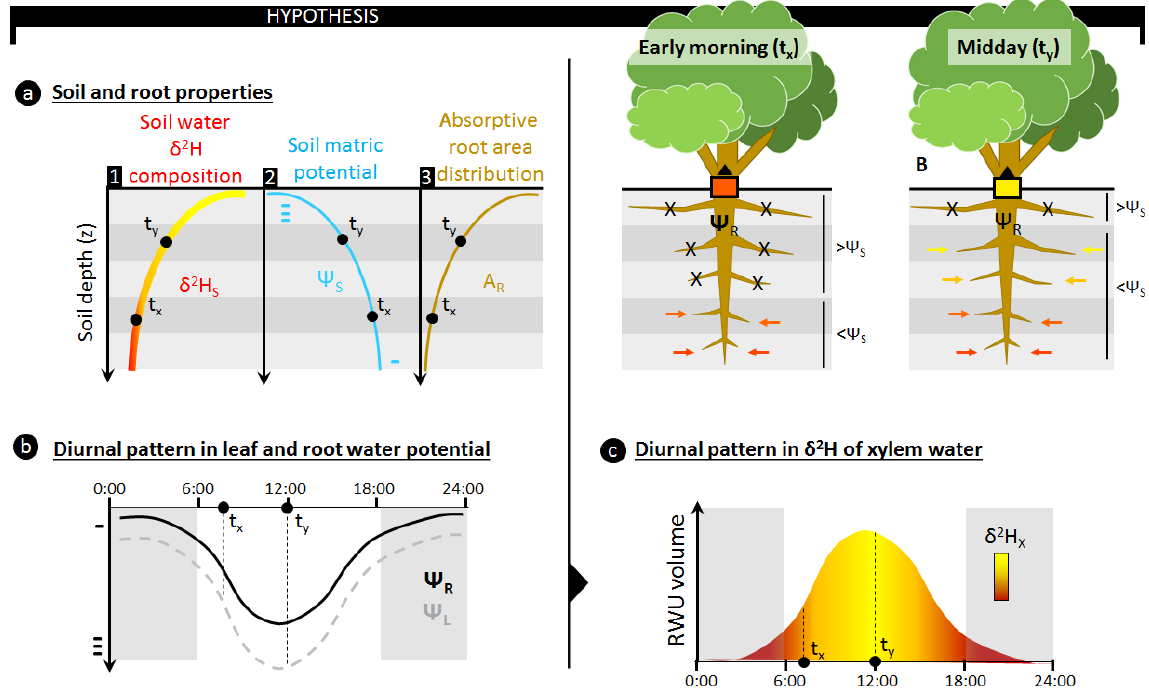
Figure 1. The use of stable water isotopes ( δ 2 H and δ 18 O) to assess the relative depth of root water uptake (RWU) requires a depth gradient in isotopic composition of soil water ( δ 2 H S ) to be present ( a , sub-panel 1) as only then can the relative contribution of different soil layers to the isotopic composition in a plant’s xylem water ( δ 2 H X ) be derived. These δ 2 H S gradients occur naturally as the result of evaporative soil drying during drought conditions; however, these conditions also result in the formation of a gradient in soil matric potential ( (cid:57) S ), ensuring an increasing (cid:57) S with depth ( a , sub-panel 2). RWU and sap flow in plants are passive processes in which water flows in the direction of decreasing water potentials. Specifically for RWU, this implies that water influx through the absorptive root area ( A R ; a , sub-panel 3) of a plant’s root is facilitated whenever the water potential in the root ( (cid:57) R ) is more negative than the surrounding (cid:57) S . As A R and (cid:57) S are generally not uniform with soil depth ( z ), the relative contribution of a specific soil layer to RWU will depend on (i) the difference between (cid:57) S and (cid:57) R in that soil layer and (ii) the relative amount of absorptive root area in that soil layer. Stable water isotope techniques assume that the δ 2 H X reflects the contribution of δ 2 H S from all soil layers. However, this does not account for the diurnal fluctuations in (cid:57) R which are invoked by the diurnal patterns in a plant’s transpiratory water demands (b) . Typically, more negative (cid:57) R values are observed when water demands are high, i.e., around midday. However, a decrease in (cid:57) R will result in higher RWU and alter the contribution of different soil layers to RWU. Specifically, dryer and shallower soil layers, with more negative (cid:57) S , could start contributing to RWU as (cid:57) R decreases (c) . For example, in the early morning (situation t x ) when (cid:57) R is high, only deeper soil layers where (cid:57) S is greater than (cid:57) R contribute to the overall δ 2 H composition of the RWU flux. As (cid:57) L and (cid:57) R decrease towards midday (situation t y ), more water can be absorbed from shallower soil layers. As the A R in these shallow soil layers is high, they strongly affect the relative contribution of δ 2 H S entering the plant. Hence, diurnal fluctuations in (cid:57) R will result in fluctuating mixtures of δ 2 H S entering the plant. As these δ 2 H S mixtures are transported along the xylem pathway, they produce variances in δ 2 H X which could complicate RWU assessments via stable water isotope analysis.